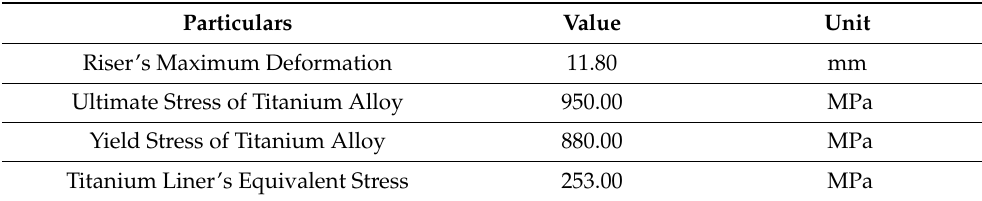
Table 12. Considerations for effect of weight per unit area for 12 design cases.